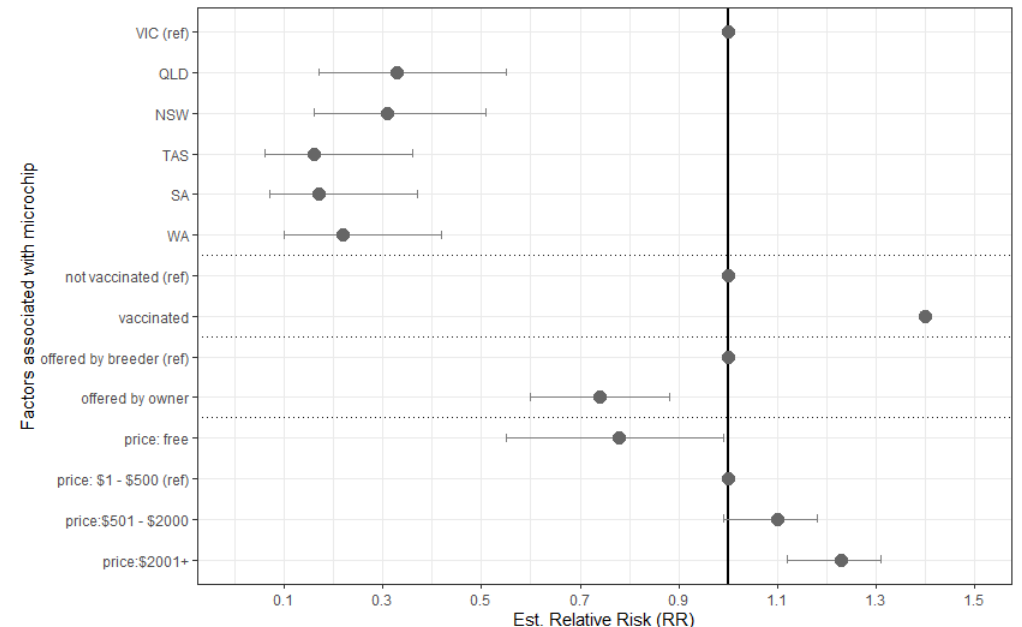
Figure 1. Estimated relative risk for predictors associated with dogs being microchipped at time of sale in 1735 unique online advertisements posted on Gumtree (webscraped on two separate days, 25 March and 8 April 2019), as found through multivariable logistic regression model. Predictors remaining were statistically significant to p < 0.005. Desexing was removed from the model due to interactions likely from the differences in procedural age.